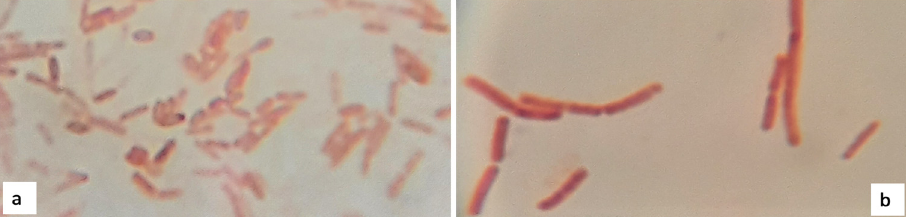
Figure 6. Gram staining: 1B ( a ) and 2D1 ( b ) appear colored in red, hence classified as Gram-negative bacteria.